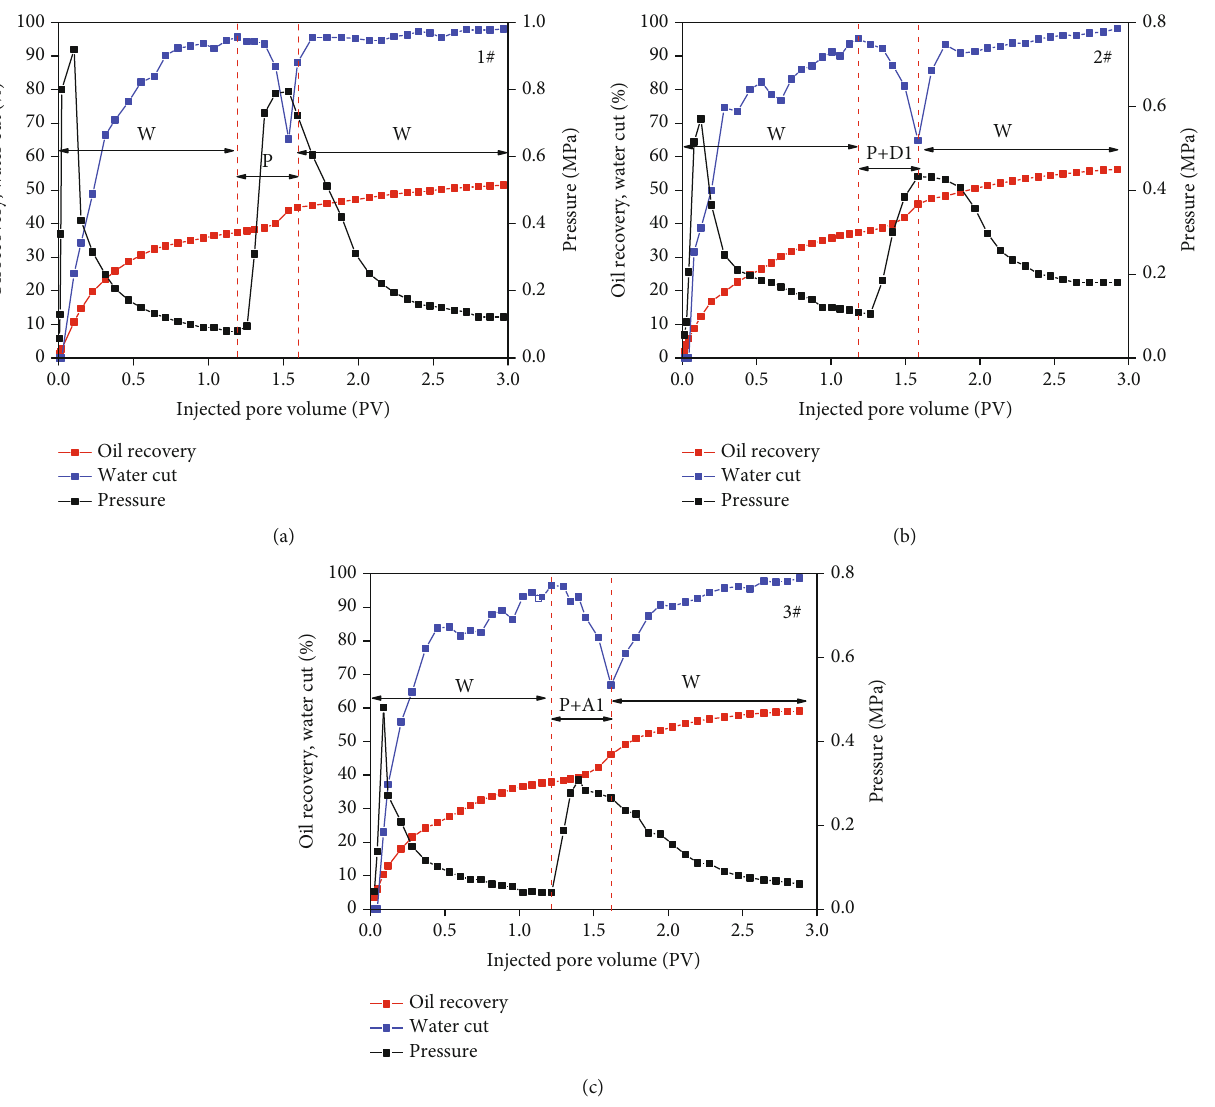
Figure 9: The oil recovery, water cut, and injection pressure versus pore volume: (a)1# — polymer fl ooding; (b)2# — polymer and D1 combination fl ooding; and (c)3# — polymer and A1 combination fl